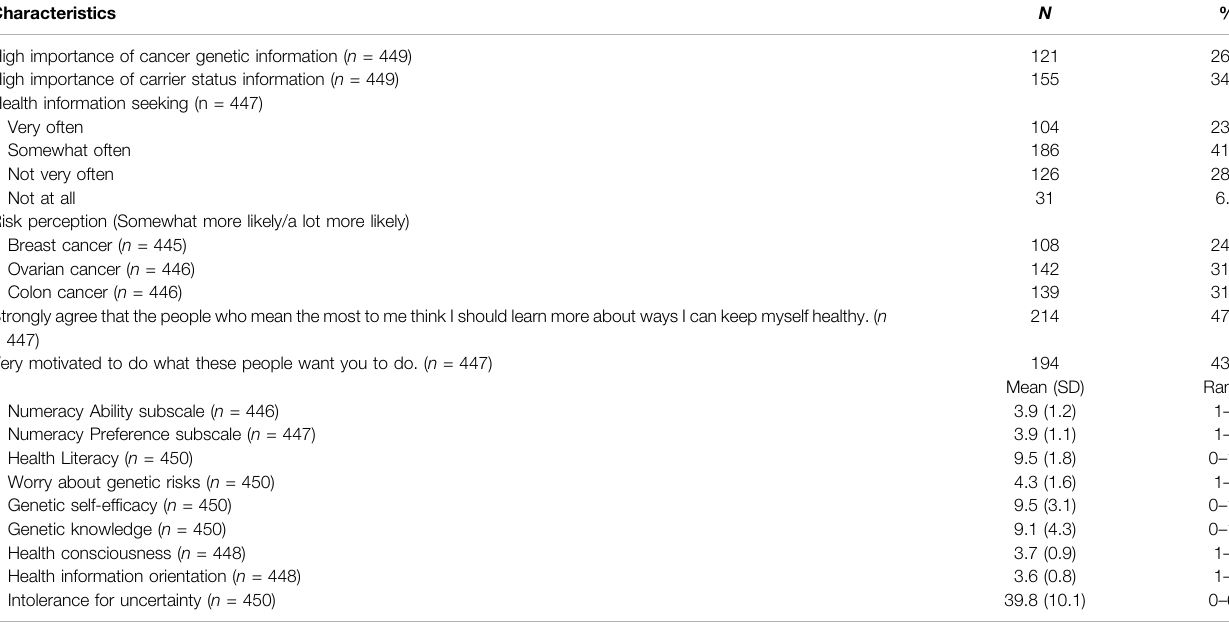
TABLE 2 | Psychosocial characteristics of 450 female respondents. Characteristics